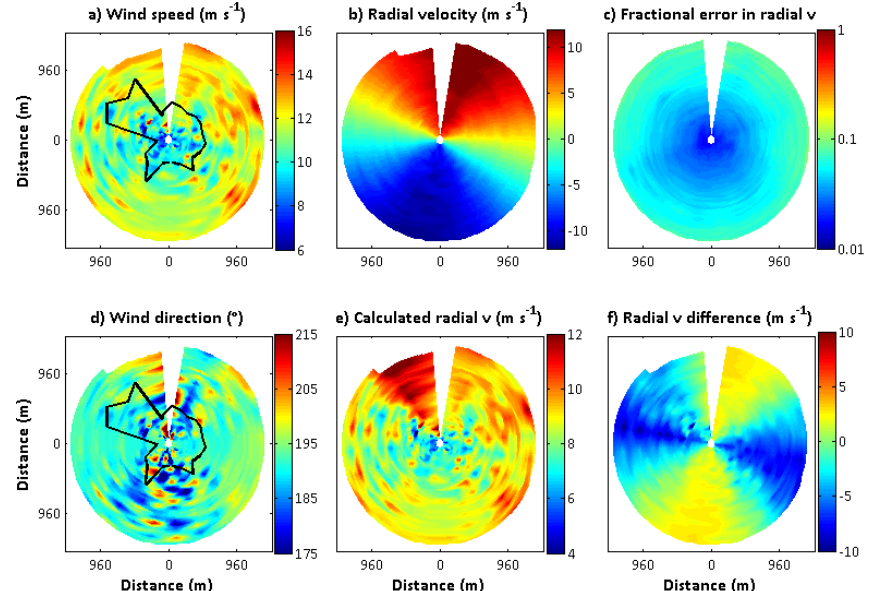
Fig. 10. Example of wind speed (a) and direction (d) near surface (with 4 ◦ elevation) using a Doppler-lidar scanning technique at Utö Island on 29 September 2012. The black curve is the border of Utö Island. A number of small islands on the northern and eastern side are not shown. Measured radial velocity (b) and its fractional error (c) , calculated radial velocity (e) and difference of calculated and absolute value of measured radial velocity (f) are also shown.